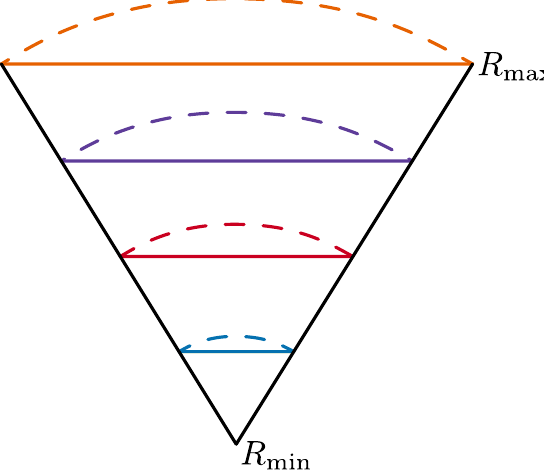
Figure 3. The radius of a polyhedron is defined as the radius of its circumscribing sphere. In this figure, all points on a solid line of a given colour have the same radius as they all have the same circumscribing sphere (i.e., lie on the same polyhedron). The corresponding spheres are shown in the same colours but with a dashed